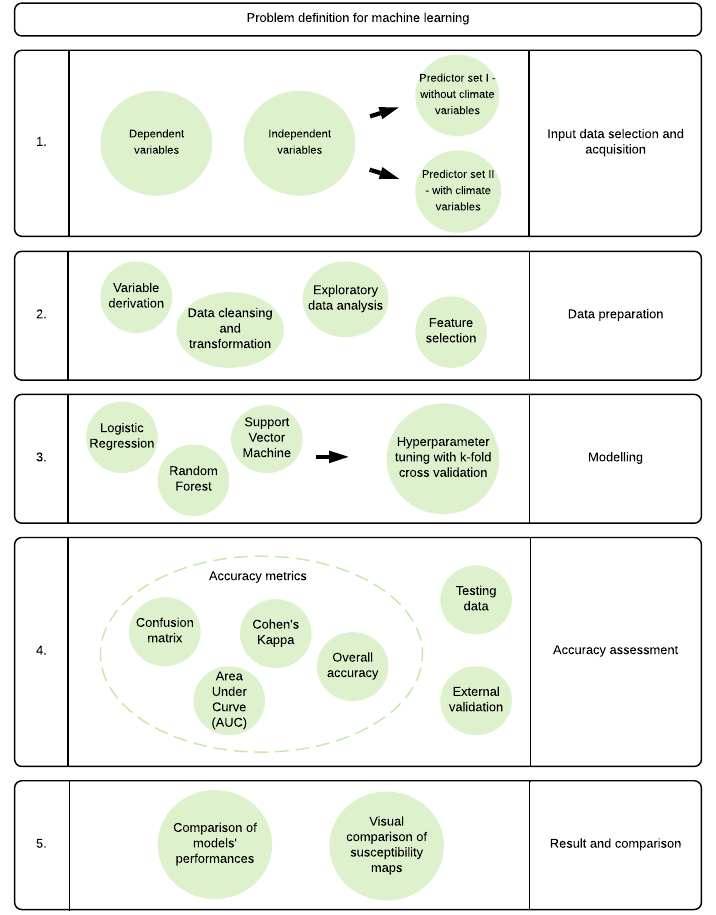
Figure 3. Methodological framework for the problem